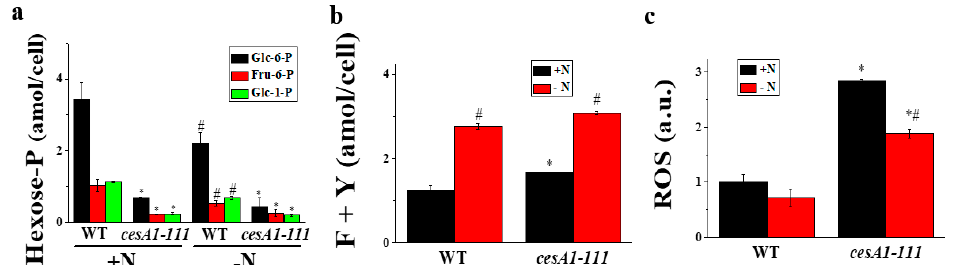
Figure 3. Quantification of hexose-P ( a ), Phe (F) and Tyr (Y) ( b ), and reactive oxygen species (ROS, c ) contents in N. salina wild-type (WT) and cesA1 mutant grown under + N and − N conditions for 3 d. In ( c ), ROS levels were determined by fluorescence intensity of DCFH-DA at 520 nm (F520) relative to that in + N WT cells. Each data point represents the mean ± SE of three biological replicates performed in triplicate. The symbols represent statistically significant differences ( p ≤ 0.05) between mutants vs. WT (*), and between +N and − N cells (#), accordingly.